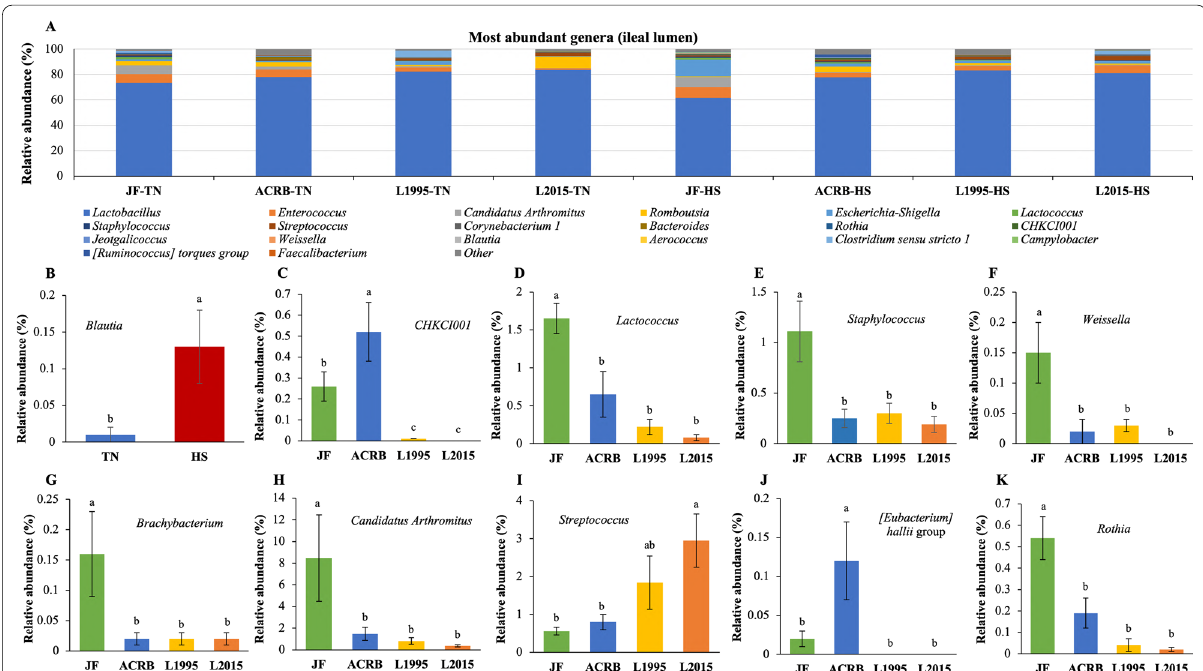
Fig. 4 Changes in relative bacterial abundance (%) in the ileal content of Jungle Fowl (JF), Athens Canadian Random Bred (ACRB), 1995 Random Bred (L1995), and 2015 Modern Random Bred (L2015) chicken lines raised under thermoneutral (TN) or heat stress (HS) condition (8 h/d; 36 °C) on d 56 at genus level. A Taxonomic profile (top 20 genera) of ileal content microbiota. B Effect of ambient temperature on the relative abundance of Blautia . Effect of genetic line on relative abundance of C CHKCI001 , D Lactococcus , E Staphylococcus , F Weissella , G Brachybacterium , H Candidatus